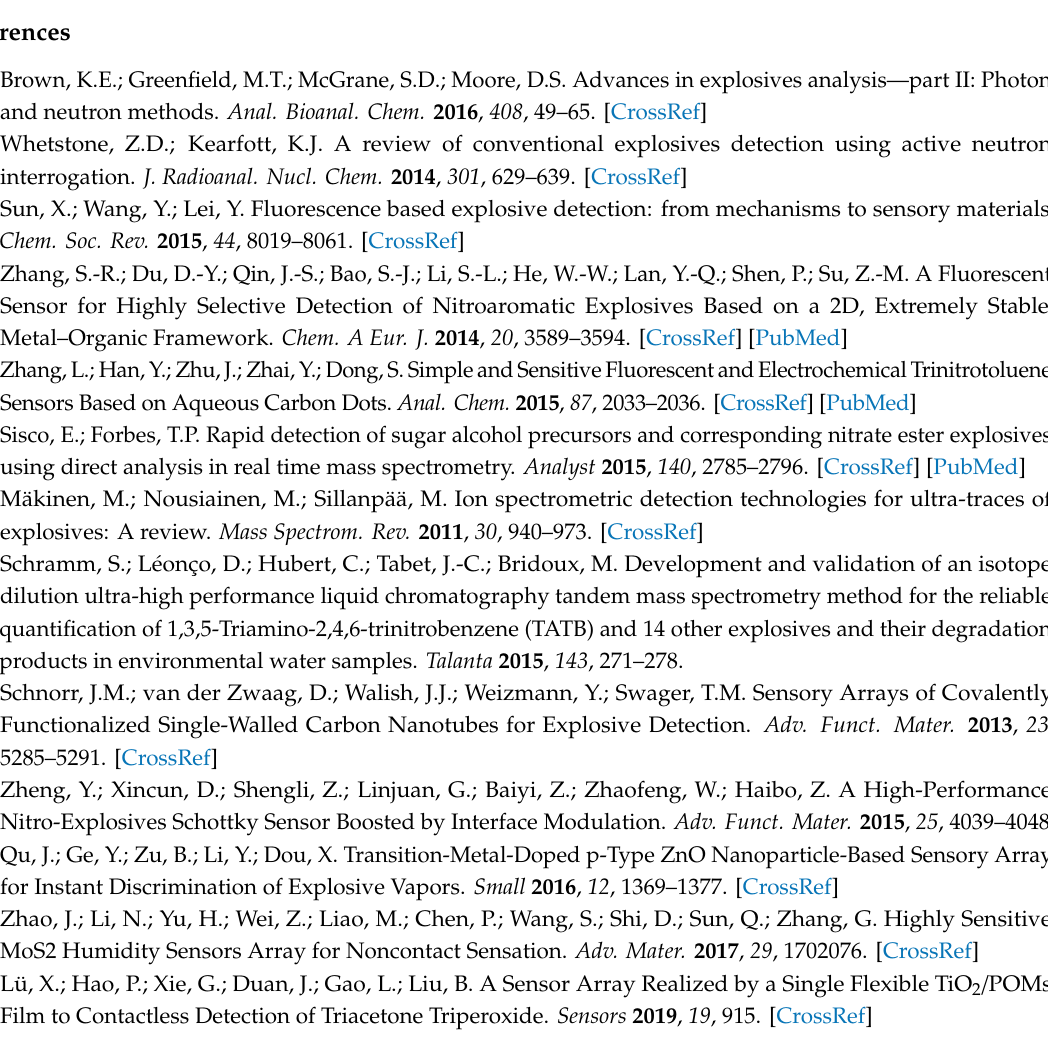
Figure S1: SEM images of TiO 2 regulated by (a) 0 mol, (b) 0.03 mol, (c) 0.06 mol, and (d) 0.12 mol of F ions. Figure S2: Response of pure TiO 2 to TNT (a), DNT (b), PA (c), S (d), AN (e) and TATP (f) under 365 nm illumination. Figure S3: Response time and recover time of pure TiO 2 to di ff erent explosives under 365 nm illumination. Figure S4: E ff ect of the humidity of TiO 2 / Aphen to TNT under the illumination of 365